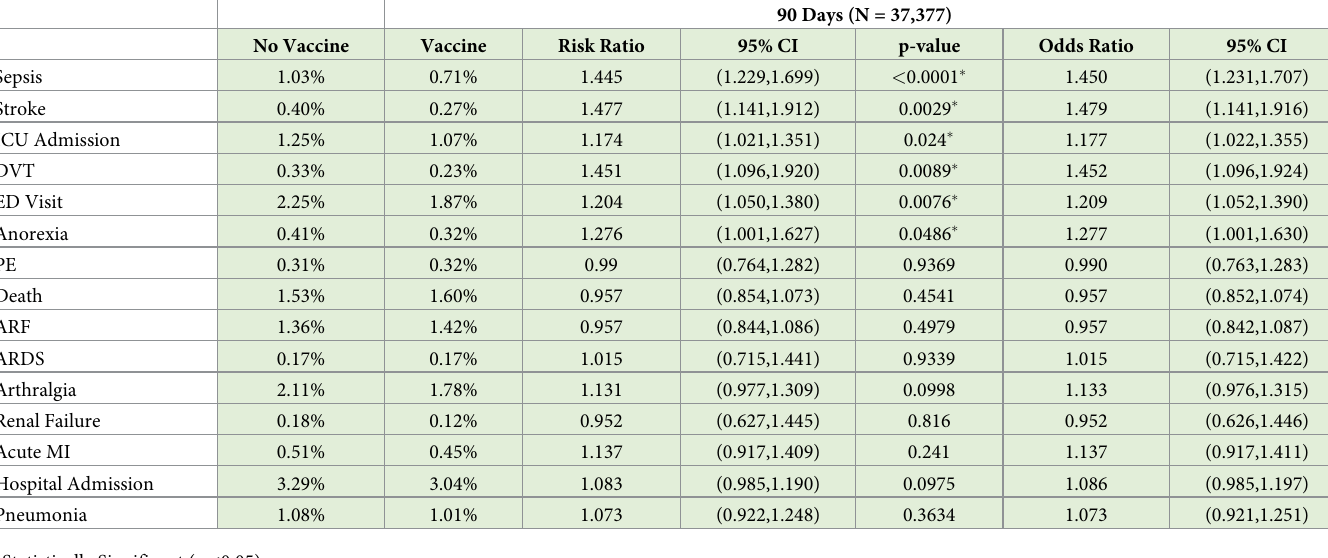
Table 4. Statistical analysis of adverse outcomes within 90 days of SARS-CoV-2-positive